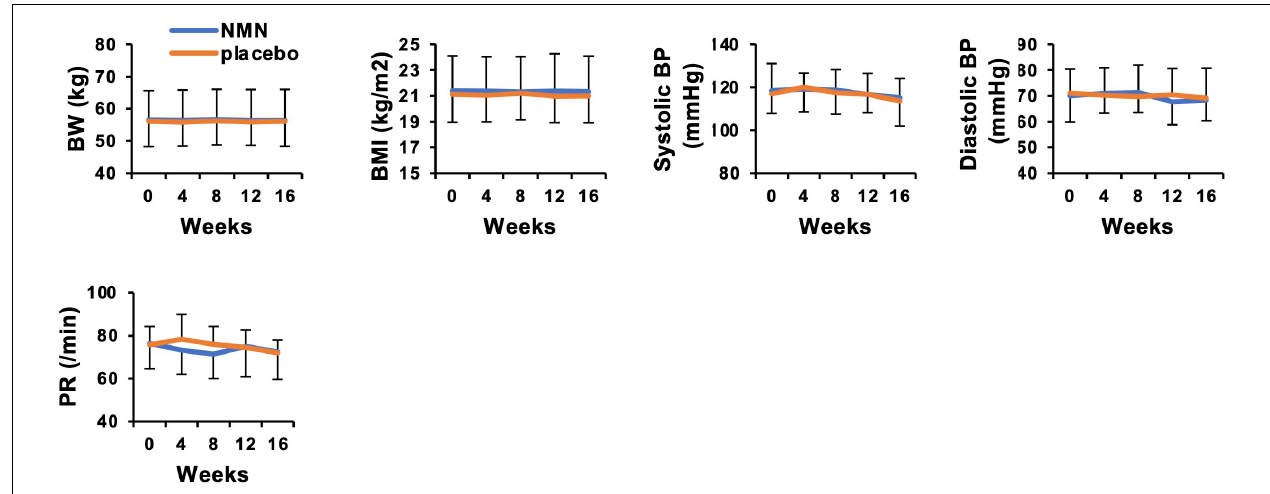
FIGURE 2 | Nicotinamide mononucleotide have no effect on body weight, blood pressure, and pulse rate. Physical measurements were performed every 4 weeks. Orange represents placebo group ( n = 15 at 0, 4, 8 weeks, n = 14 at 12, 16 weeks) and blue represents NMN group ( n = 15). Data are represented as mean ± SD. BW, body weight; BMI, body mass index; BP, blood pressure; PR, pulse rate.